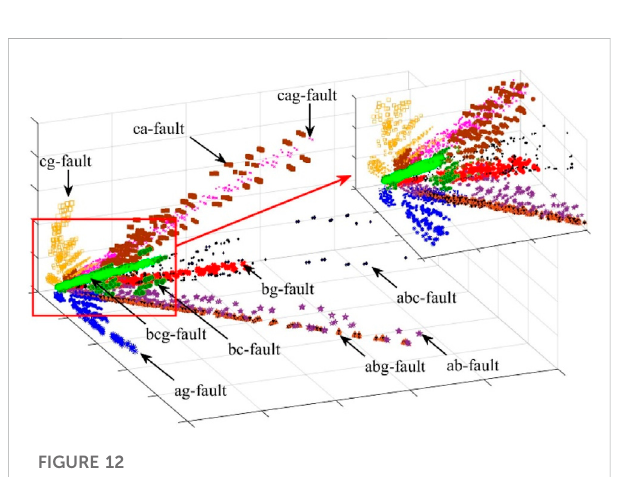
FIGURE 12 Distribution of input features for different fault